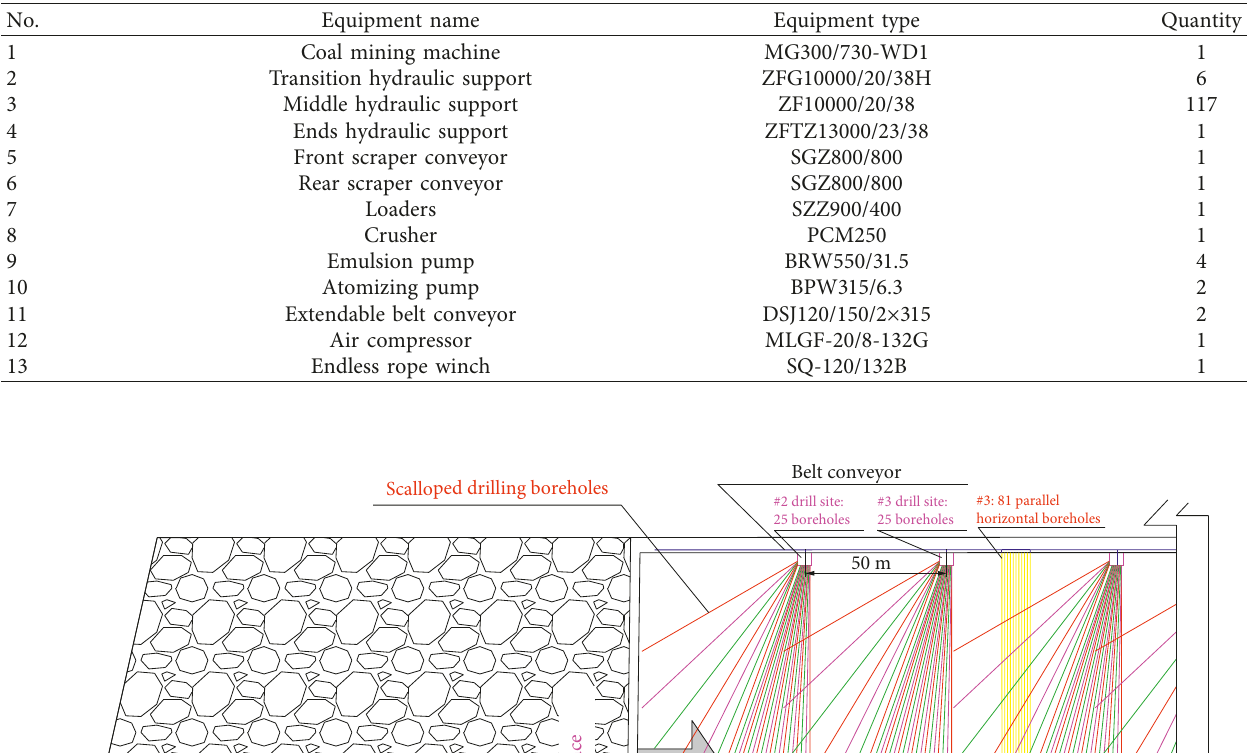
Figure 1: Layout of ZF301 working face and gas drainage borehole. Table 1: Working equipment for ZF301 longwall face.